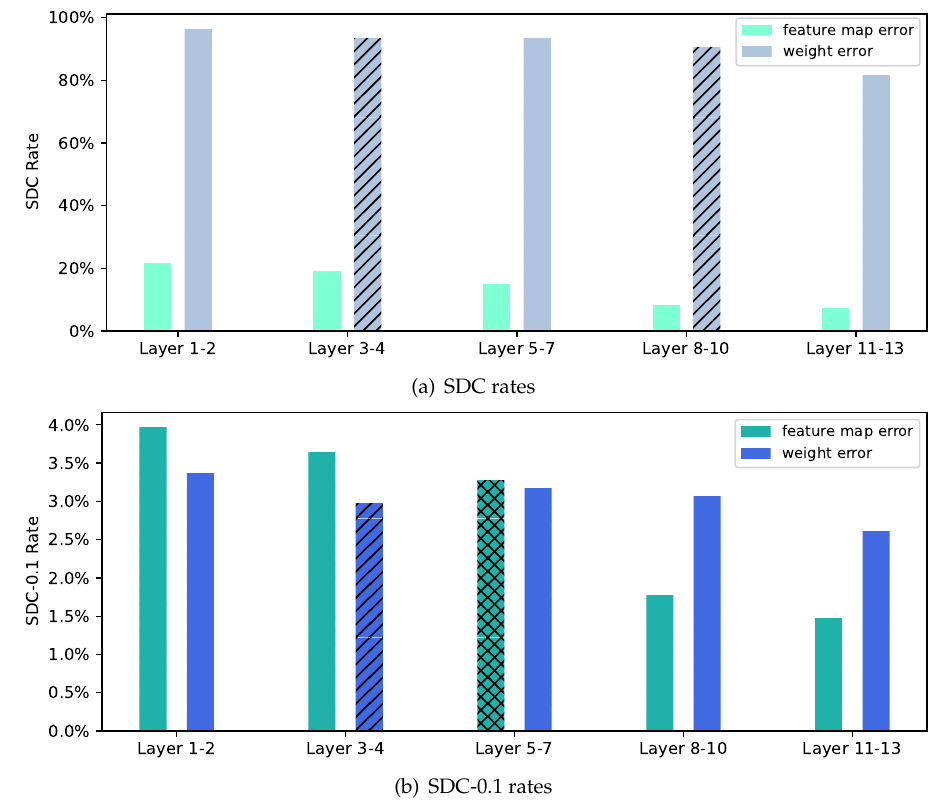
Figure 4. Feature map error and weight error injected in different convolutional layers in a VGG16 network: (a) shows SDC rates for errors injected in different layers; (b) shows SDC-0.1 rates for errors injected in different layers.